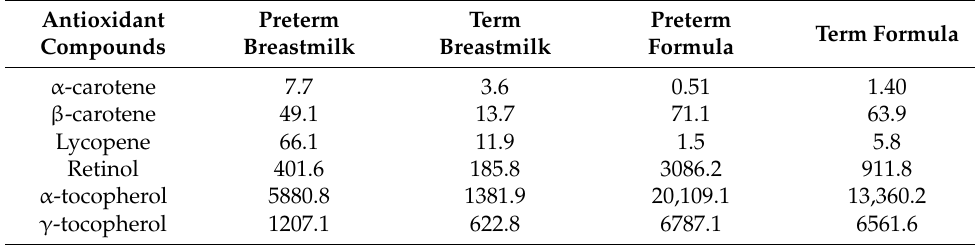
Table 2. Exogenous antioxidants in breast milk compared to formula milk. (Modified from Hanson et al.,